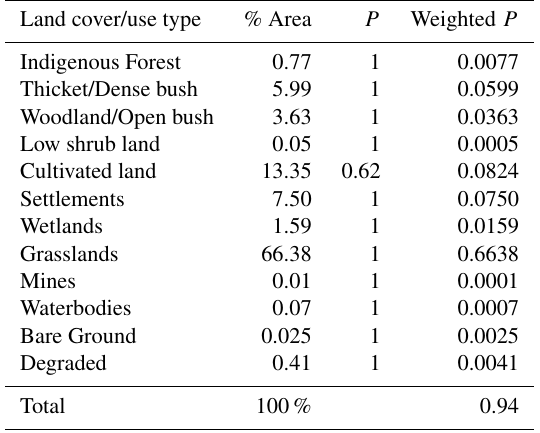
Table 3. Modified Universal Soil Loss Equation (MUSLE) erodi- bility values for the study area.